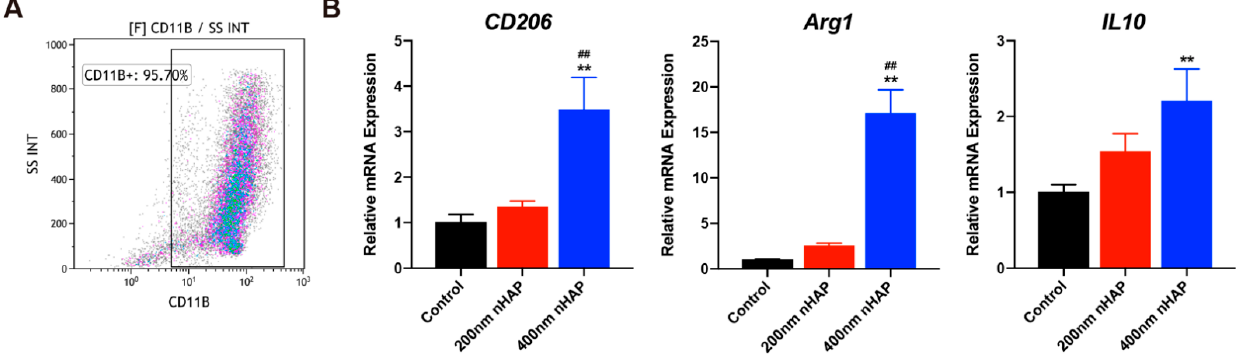
Figure 2. 400 nm nHAP regulates macrophage polarization. ( A ) Percentages of CD11b-positive macrophages by flow cytometry. ( B ) RT-PCR results for CD206, Arg1 and IL10 mRNA in macrophages on day 2 with nHAP. (** and ## represent p < 0.01 compared with control and 200 nm nHAP, respectively).